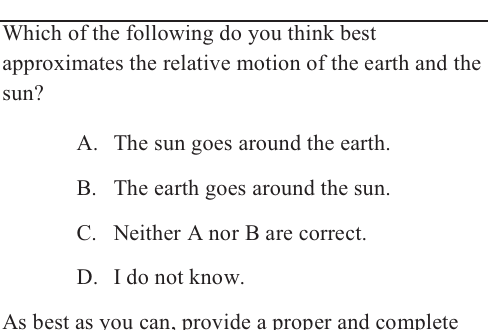
FIG. 1. Pretest and posttest given to all students at the